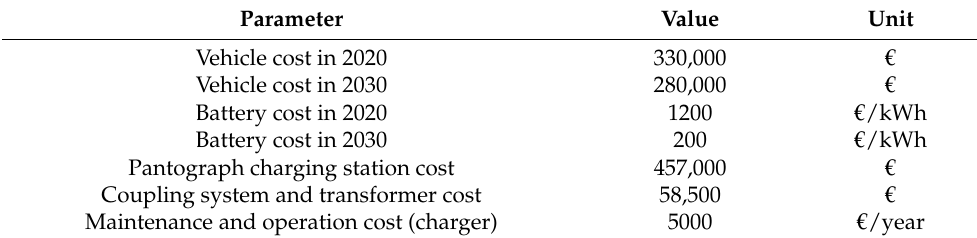
Table 6. Economical parameters for the pantograph charging